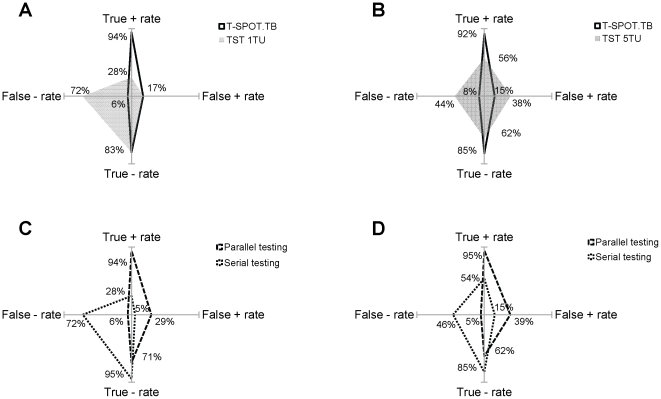
The deviation features of the T-SPOT.TB, TST in single or combination way.The deviation from the gold standard test was compared between T-SPOT.TB and TST1TU PPD (A), T-SPOT.TB and TST5TU PPD (B), and between the combination in parallel and serial way for these two comparisons (C, D). The north, south, east and west poles in each panel represented 100%of the true-positive rate, true-negative rate, false-positive rate, and false-negative rate, respectively, and each observed rate located between the top poles of the axes (100%) and the central origin (0%). In A and B, the shape formed by connecting the diagnostic rates of T-SPOT.TB was outlined by the dark lines and the shape of TST were filled with grey color. In C and D, parallel testing was outlined by dashed lines, and serial testing by dotted lines.